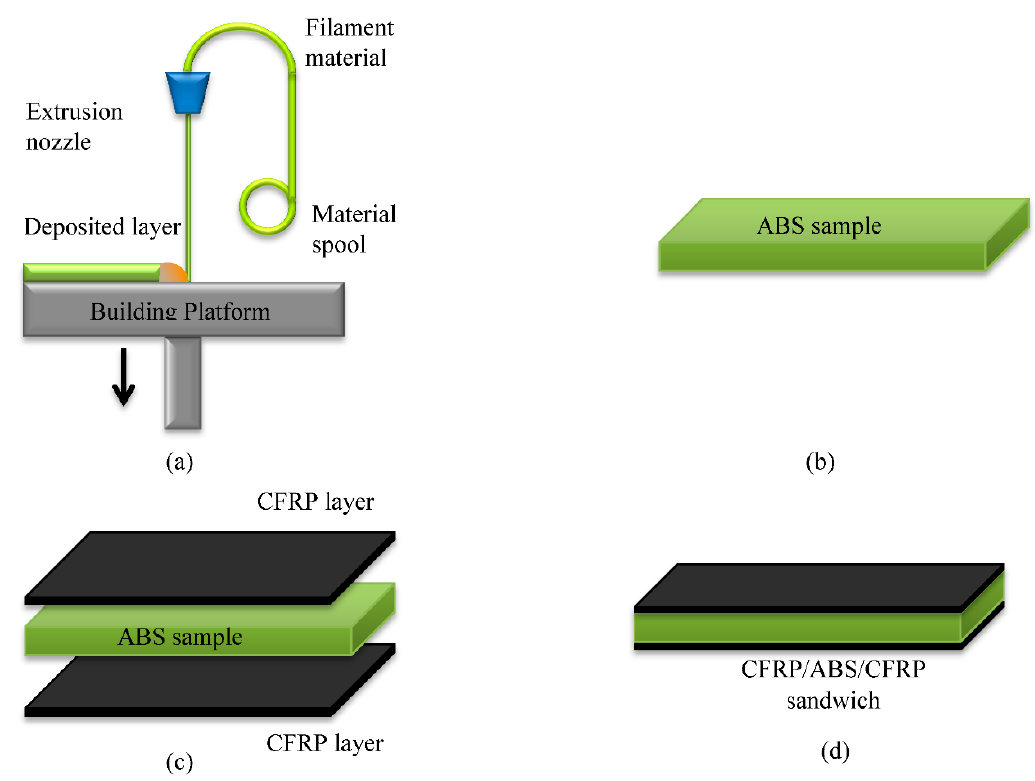
Figure 2. A schematic of the fabrication of CFRP/ABS/CFRP sandwich composite structure ( a ) FDM process; ( b ) ABS sample; ( c ) laminate the ABS with CFRP layers; ( d ) CFRP/ABS/CFRP sandwich.